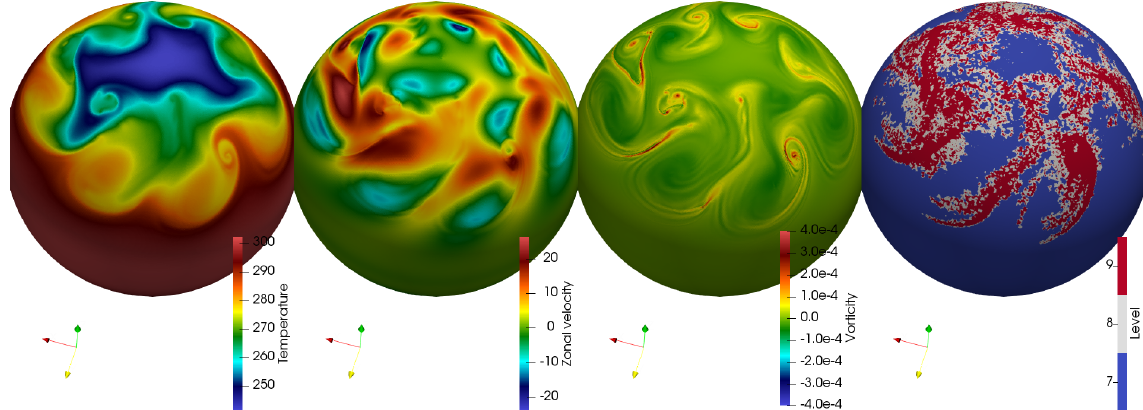
Figure 5. Adaptive Held and Suarez (1994) general circulation experiment at t = 500h with maximum resolution of 1 / 8 ◦ used for the strong parallel scaling results shown in Fig. 4. Results are shown at the vertical level corresponding to 850hPa. The rightmost figure is the adaptive grid with a grid compression ratio of about